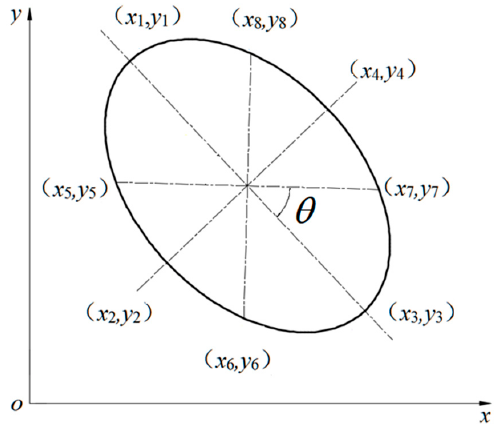
Figure 2. Schematic diagram of ellipse reference point.